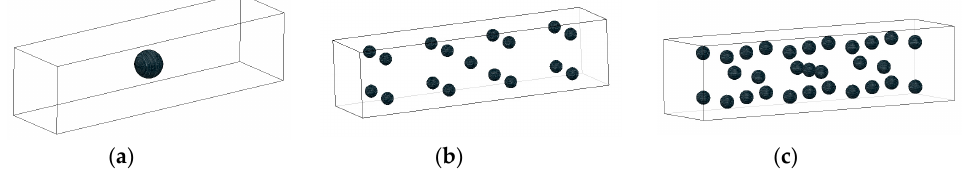
Figure 10. Model of breaking strength (Strain). ( a ) Aggregated completely, ( b ) dispersion ratio of 50%, ( c ) dispersion ratio of 100%.